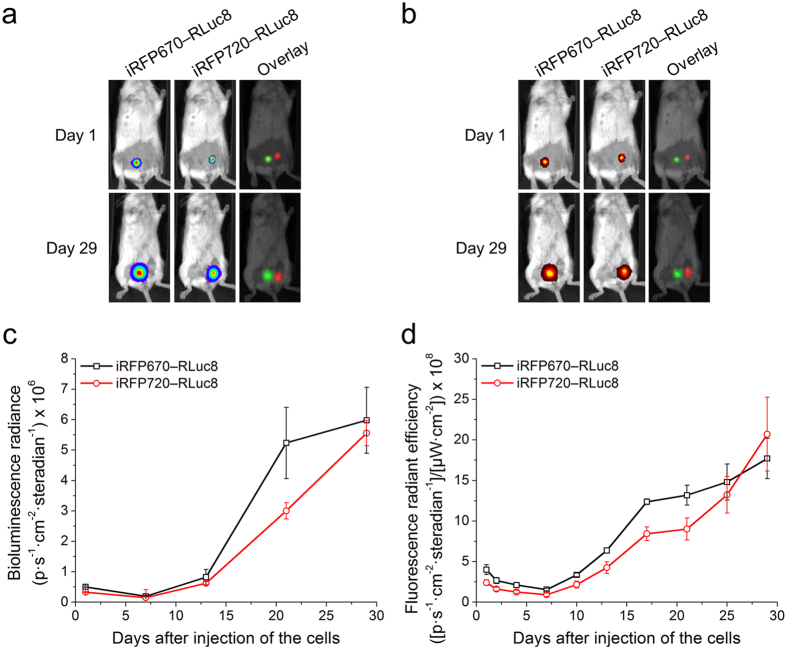
Growth of xenograft tumors expressing iRFP670—RLuc or iRFP720—RLuc in mice.(a) BLI and (b) FLI of 2.5 × 106 MTLn3 cells orthotopically implanted into the mammary fat pads of mice with images taken on the 1st and 29th day of tumor growth (dorsal view). (c) Values of bioluminescence signal for the images in (a). (d) Values of fluorescence signal for the images in (b). Error bars, s.d. (iRFP670—RLuc8 tumors n = 5, iRFP720—RLuc8 tumors n = 6).